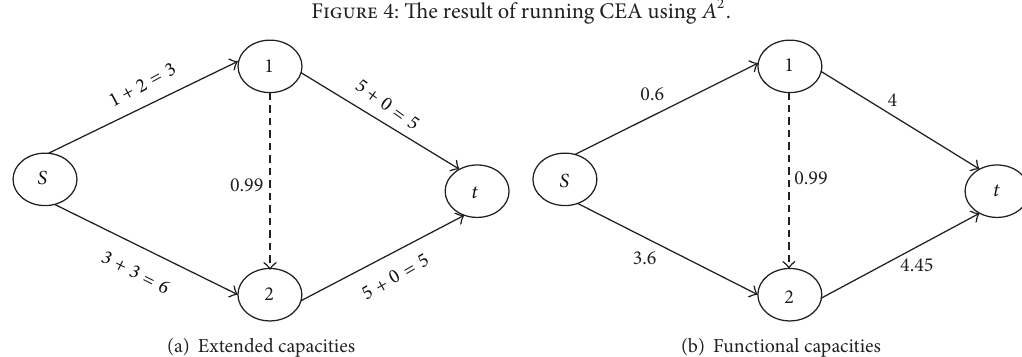
Figure 5: The result of running CEA using 𝐴 5 .